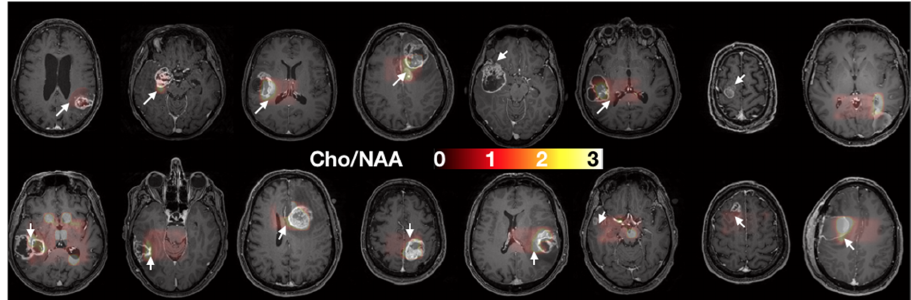
Figure 2. Axial slices of each patient prior to surgery. Spectroscopy (Cho/NAA) maps overlying T1 contrast-enhanced images were used to determine the two sites of sample collection (i.e., one target in the CNI > 2 region, white arrows, and one target control in the CNI < 2 regions. When no CNI > 2 was present, the maximal CNI value was used for the target.